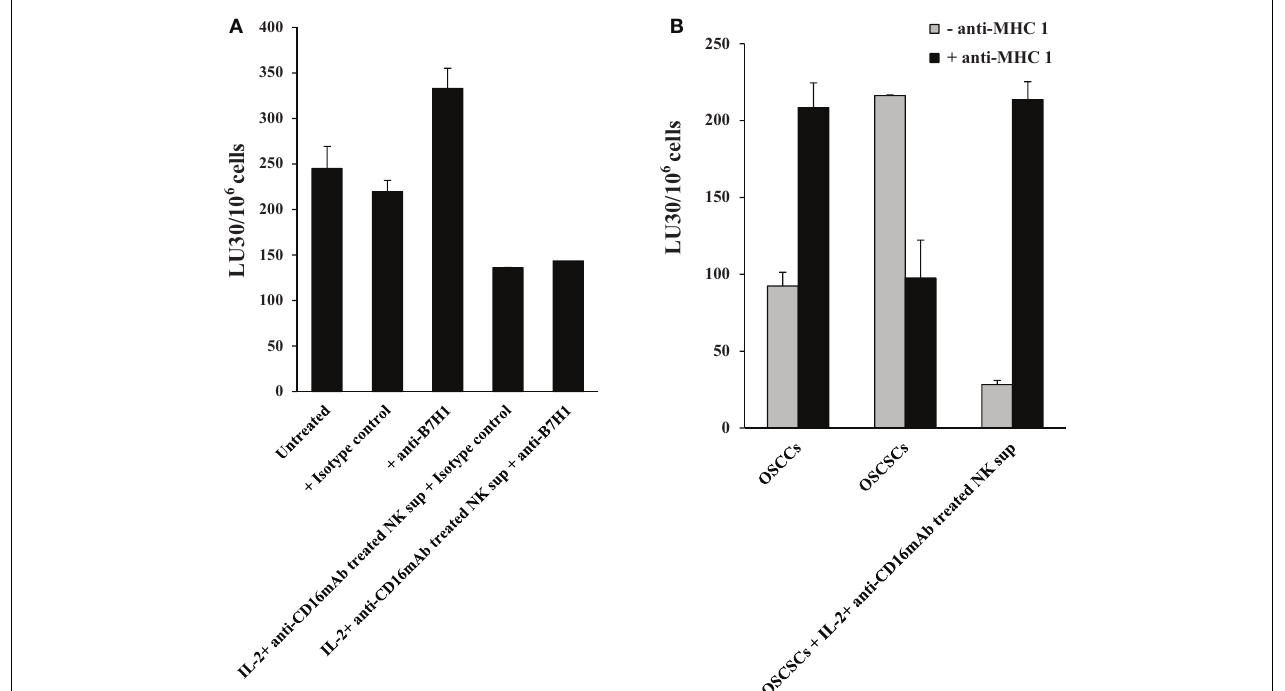
mAb-treated NK cells for 5days before they were washed, 51 Cr-labeled, and treated with either isotype control antibody or anti-MHC class I antibody (1:100) for 10min prior to their use in the cytotoxicity assay against IL-2-treated (1000units/ml) NK cells. OSCCs were also 51 Cr-labeled and treated with and without isotype control or anti-MHC class I (1:100) antibodies before they were used in the cytotoxicity assay against IL-2-treated NK cells.To prepare NK cell supernatant for the treatment of OSCSCs, NK cells were treated with the combination of IL-2 (1000units/ml) and anti-CD16 mAb (3 µ g/ml) for 18–24h before the supernatants were harvested and added to OSCSCs.The treatment of IL-2 (1000units/ml) was also carried out for 18–24h before their use in the cytotoxicity assay. Percent cytotoxicity was determined at different effector to target ratio, and the lytic units 30/10 6 cells were determined using inverse number of NK cells required to lyse 30% of the tumor cells × 100 (B)